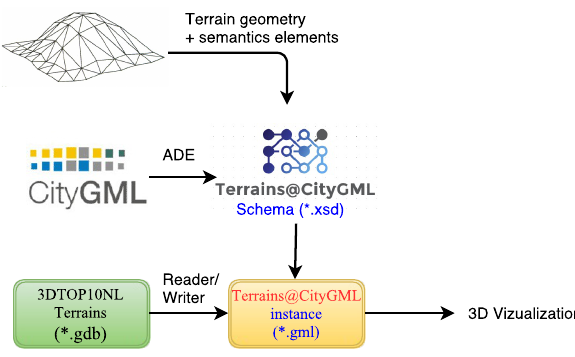
Figure 7: Workflow for proposed solution. CityGML/GML are extented to store terrain geometry and semantics as